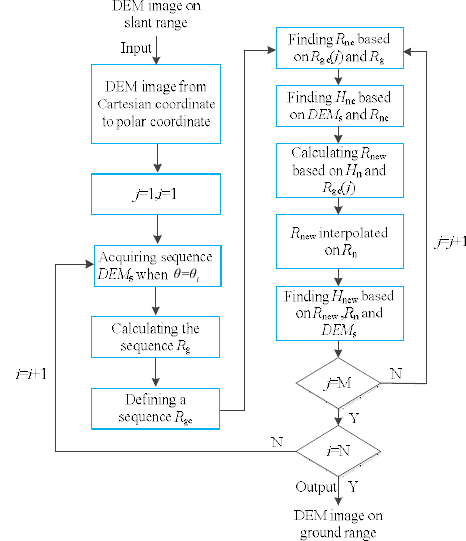
Figure 10. The polar coordinate transformation method proposed in this paper.